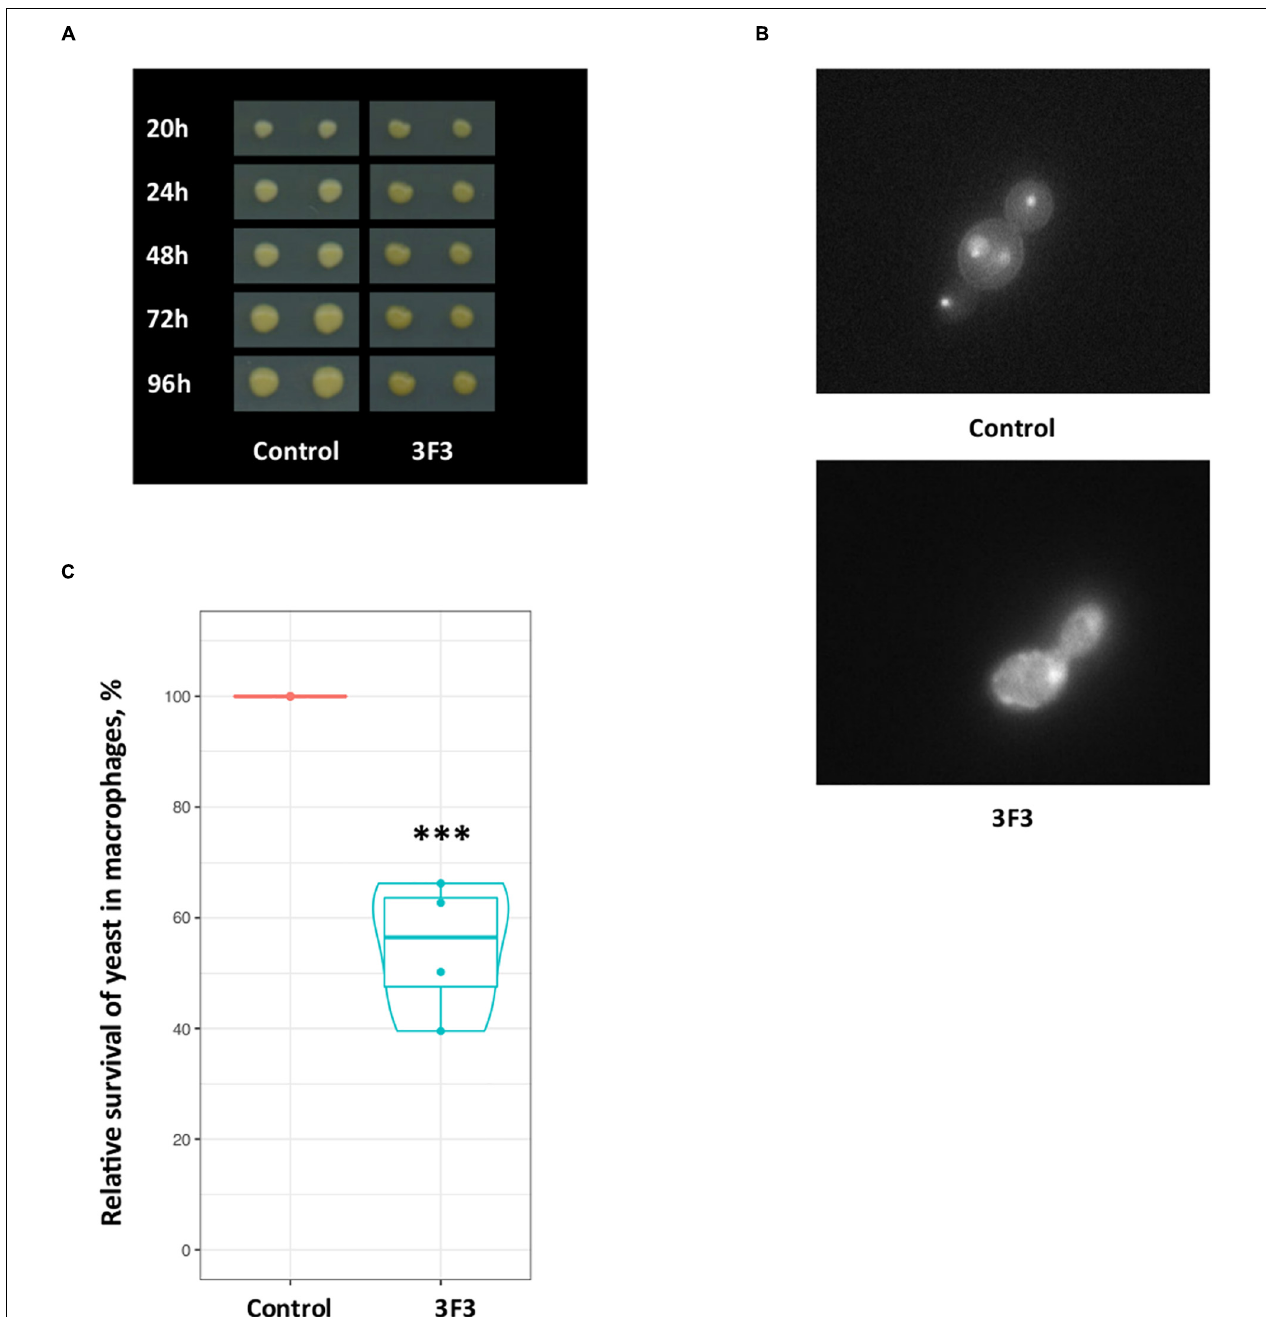
FIGURE 6 | Candida glabrata CAGL0K11968g contributes to vacuolar morphology and survival in macrophages. (A) On the medium with pH indicator bromocresol green the 3F3 strains had darker yellow color than control strain, indicating more acidic pH. (B) Fluorescent microscopy images of C. glabrata strains after staining showing abnormal vacuolar morphology of the 3F3 strain. (C) The transformant 3F3, which carries an antisense CAGL0K11968g gene, displayed 50% loss of viability in our macrophage model. The experiment was performed in four replicates with cells originating from blood of two donors. The plot is based on data of four replicates. The control strain data (CFU) was set as 100% and used to normalize data. According to Poisson Regression analysis of raw data, the 3F3 strains CFU response was significantly different ( ∗∗∗ p -value ≤ 0.0005).